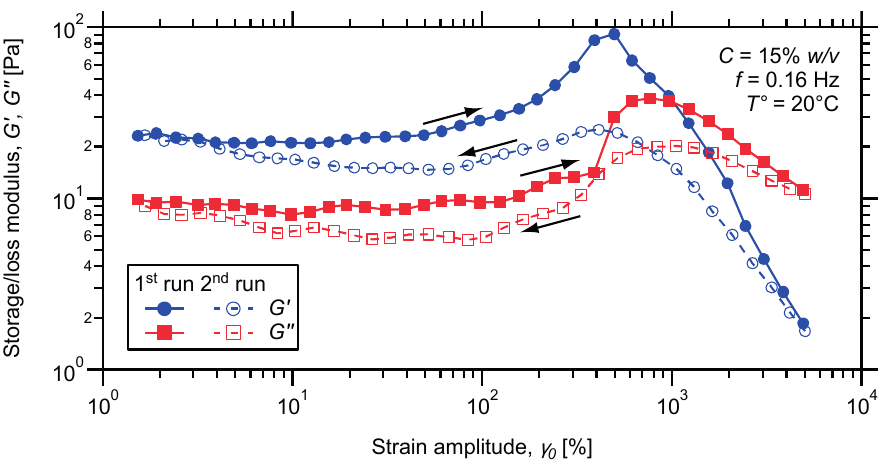
Figure 7. Oscillatory strain sweeps (arrows indicate up and down sweeps) on a metallo-supramolecular hydrogel prepared from P(DMAMEA 200 - co -TpyMA 4.5 ) copolymer and 0.5 eq of Co (II)